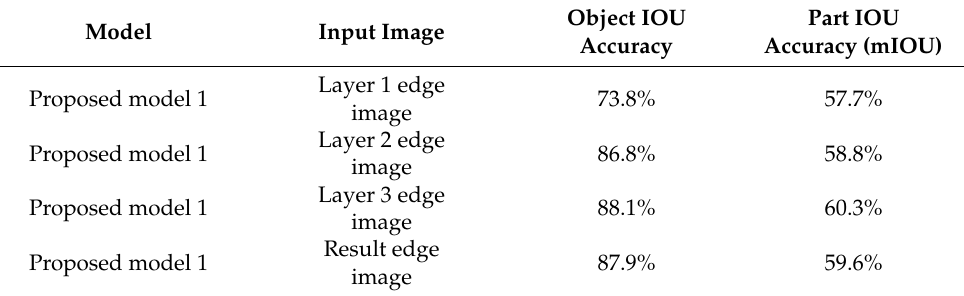
Table 6. The object and part IOU accuracy of the proposed model 1 for each edge